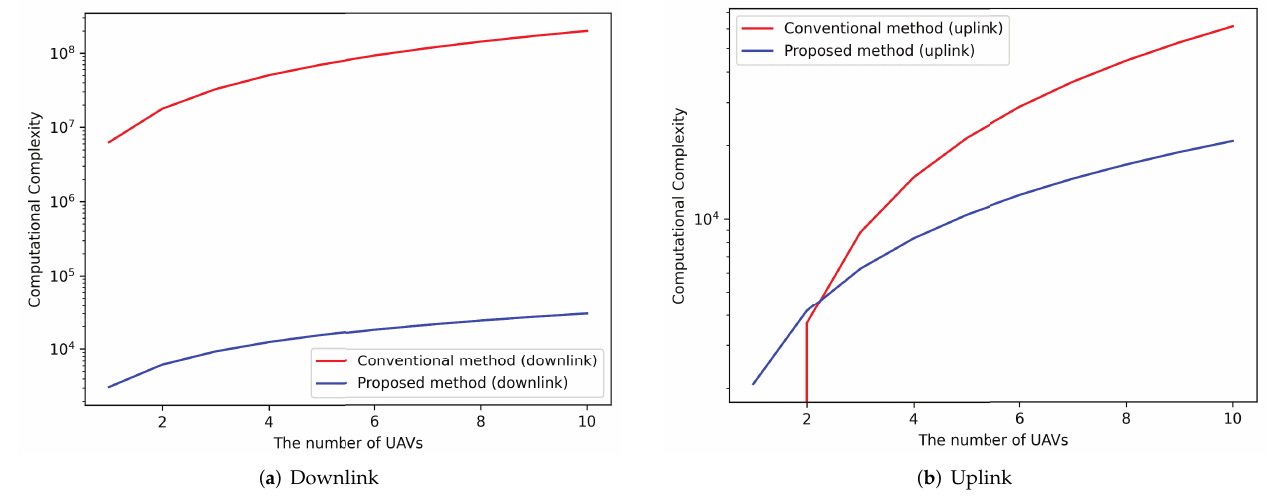
Figure 3. Computational complexities of the conventional scheme and the proposed scheme.